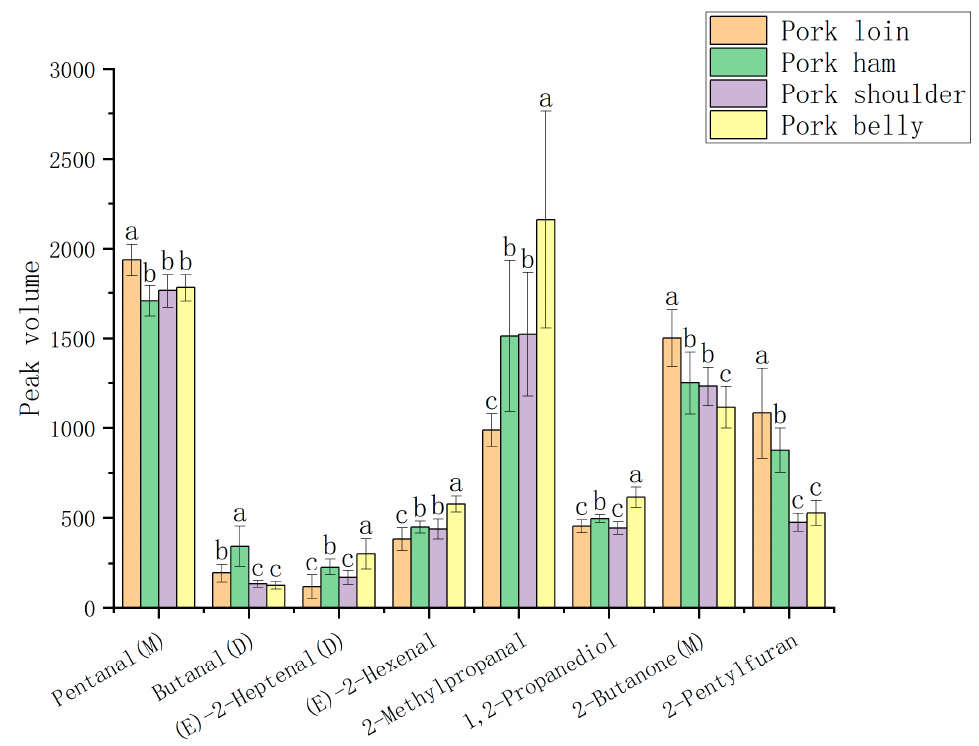
Figure 5. Significant differences of certain compounds in four muscles of pork (note: different letters (a, b, c) indicate a significant difference ( p < 0.05) according to one-way analysis of variance). Table 1. Qualitative analysis of pork volatile organic compounds.